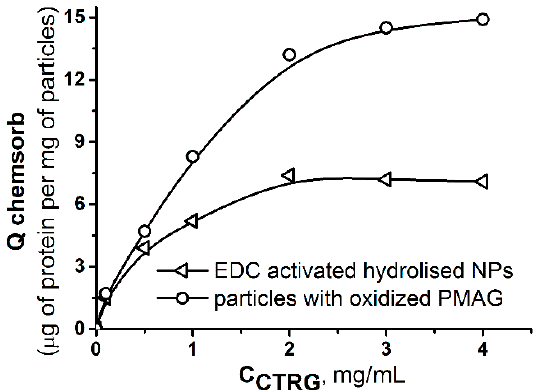
Figure 8. Isotherms bound for CTRG chemisorption on the surface of the PLA nanoparticles with activated carboxylic groups and covered with ox-PMAG. Conditions: 0.01 M sodium borate buffer solution, pH 8.5, 25 °C, 300 rpm.